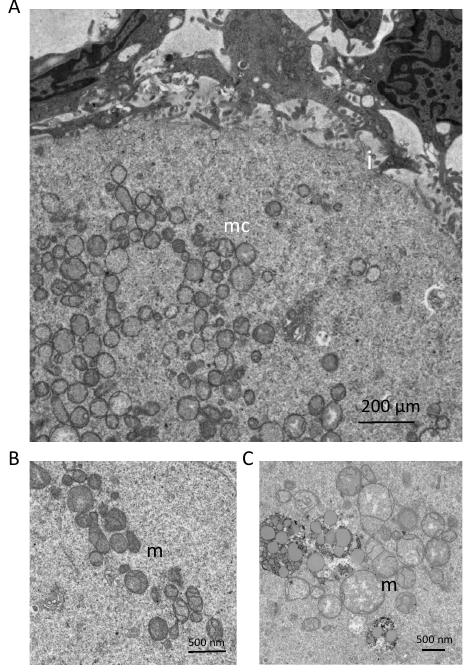
Figure 2. Mitochondrial ultrastructural features, as determined by transmission electron microscopy, in primary-stage oocytes contained within follicles of reproductive-age human ovaries: ( A ) Mitochondria are localized as clusters (mitochondrial clusters; mc) within oocytes. The oocyte-granulosa cell interface (i) is also depicted, and demonstrates areas of interdigitation between the oocyte and surrounding granulosa cells. Scale bar = 200 µm. ( B , C ) Mitochondrial morphology (m) depicted at two magnifications reveals that most mitochondria exhibit an ovoid morphology, dense matrices, and few cristae. However, a large variation in mitochondrial size can be observed, along with multiple examples of mitochondria that fall outside of the characteristic morphology described above. Tissues were collected and prepared for TEM by non-coagulative aldehyde fixation, followed by sectioning on an ultramicrotome. Images were acquired using a JEOL JEM-1010 transmission electron microscope.